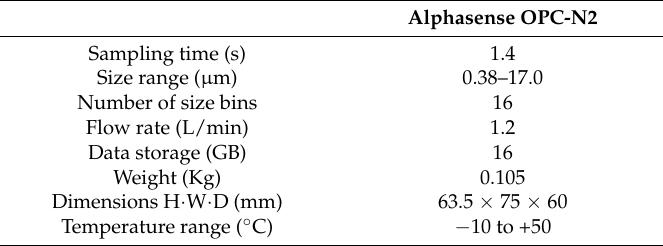
Table 1. Summary of Alphasense OPC-N2 operational settings